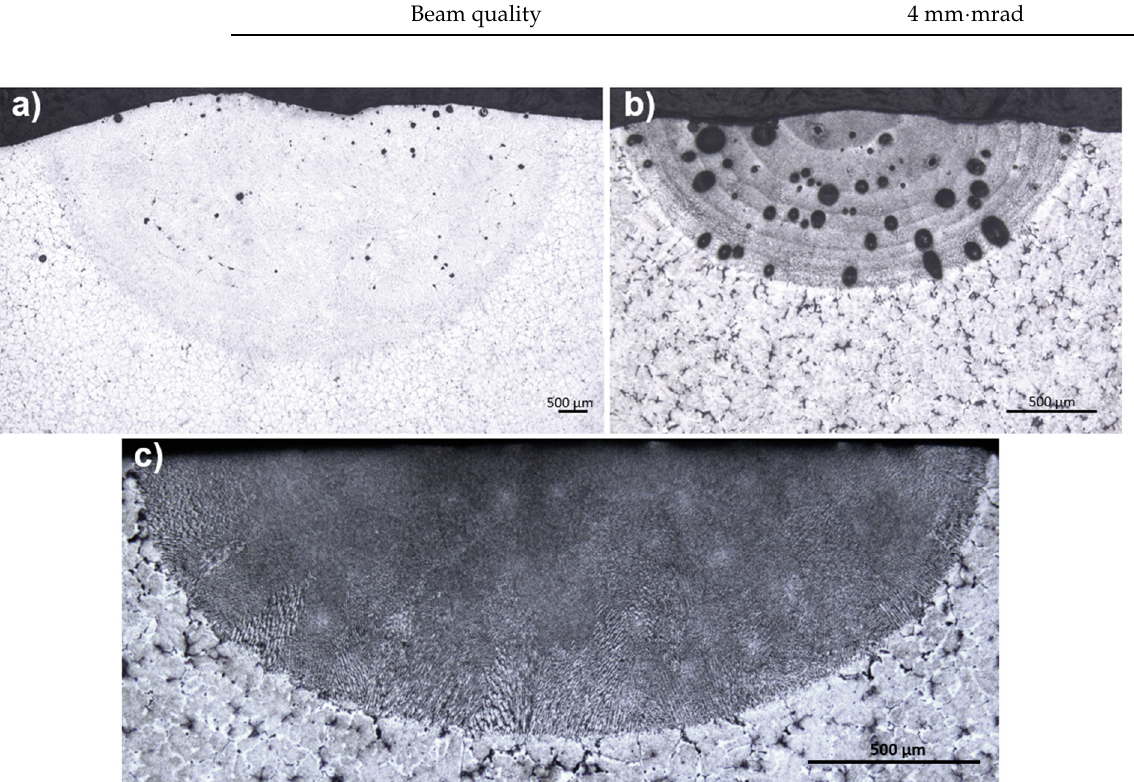
Figure 3. Optical images of laser welded AlMg3 alloy cross-sections: ( a ) weld seam conducted with laser beam tilt at 40° and 12 passes, ( b ) weld seam obtained by single irradiation with a beam perpendicular to the sample surface and ( c ) weld seam with the laser beam tilt at 40° and 2 passes.